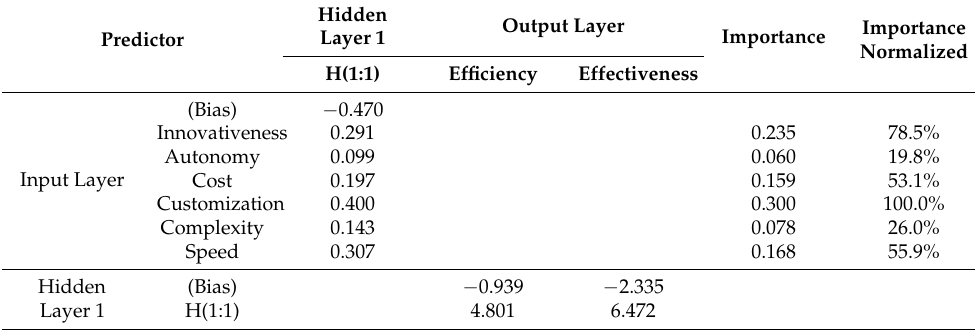
Table 3. Predictors for digital transformation in project management.